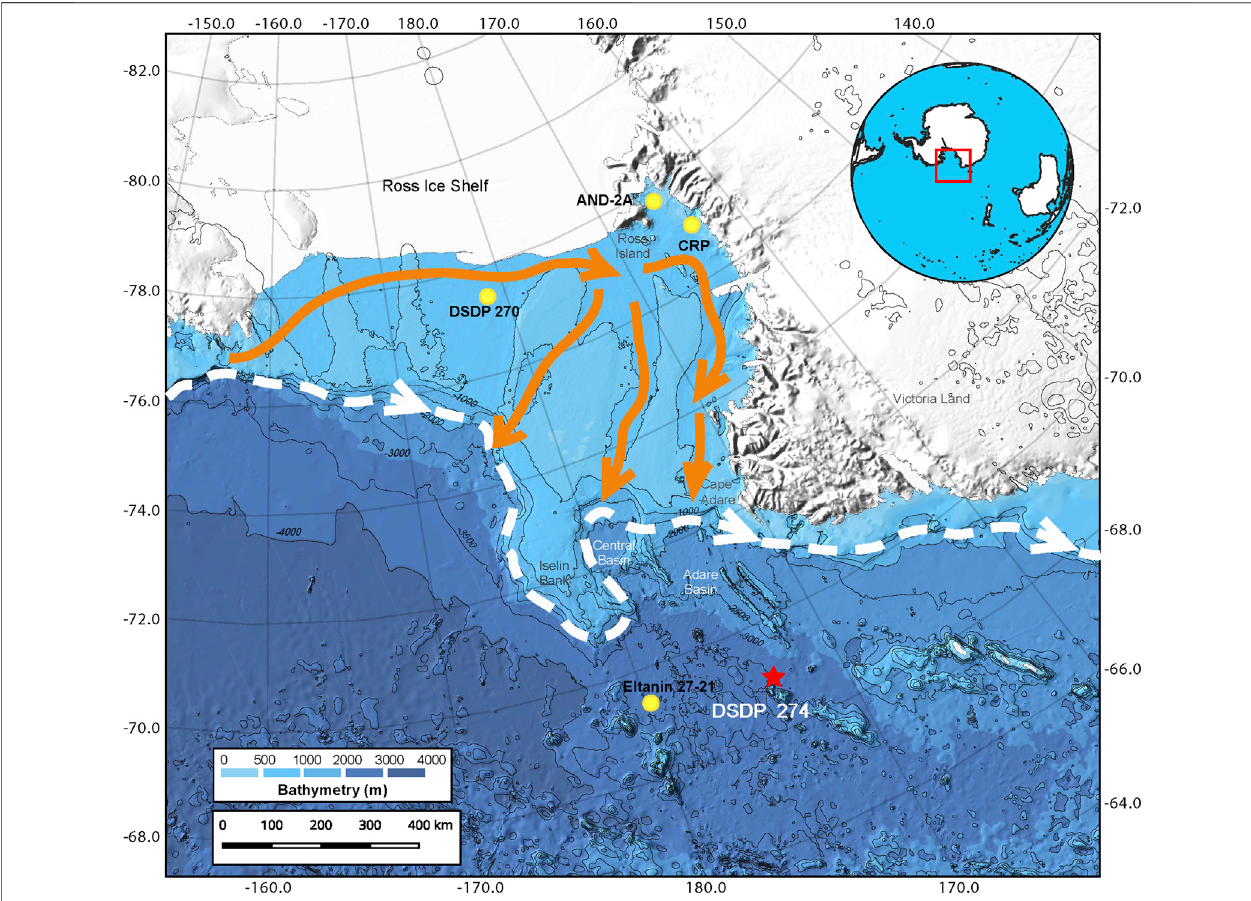
FIGURE 1 | Map of Ross Sea with schematic representation of present-day Antarctic Slope Current (dashed white line) and the continental shelf current fl ow (orange lines) (Ainley and Jacobs, 1981; Whitworth et al., 1995; Orsi and Wiederwohl, 2009). Location of DSDP Site 274 is indicated by a red star. DSDP 270, AND-2A, Eltanin27 – 21andCRParealsoshownbecausetheyarereferencecoresinthearea(respectively,Kulhaneketal.,2019,Jovaneetal.,2019;Jovaneetal.,2008;Roberts et al., 2013).